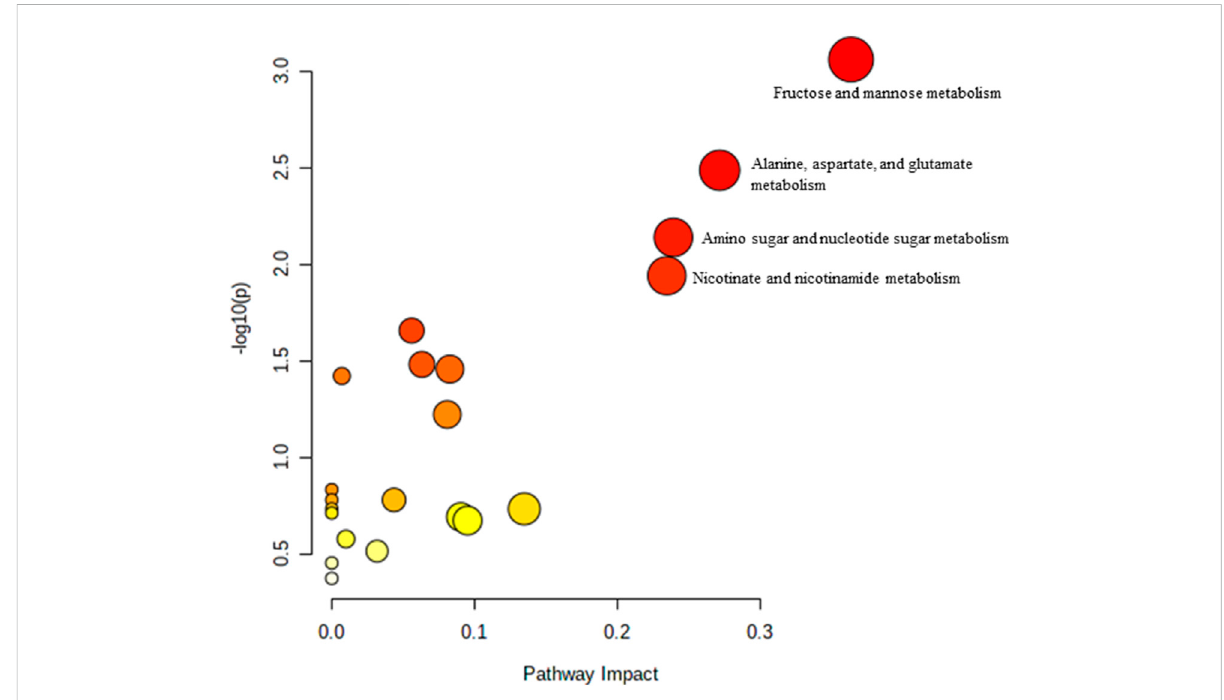
FIGURE 6 Biochemical pathway analysis of metabolites pro fi led for AC vs.